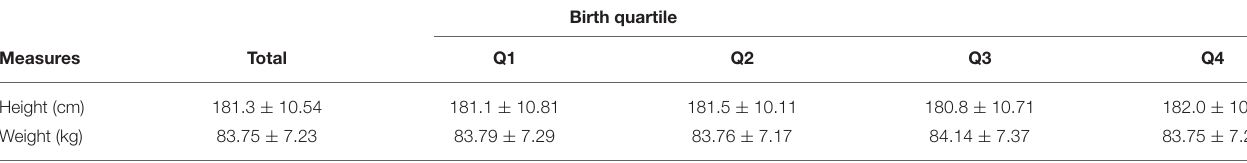
TABLE 5 | Anthropometric measures of CHL players as a function of birth quartile.